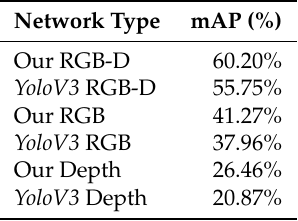
Table 4. Mean precision values in respect to IoU > 0.5 for each of our trained